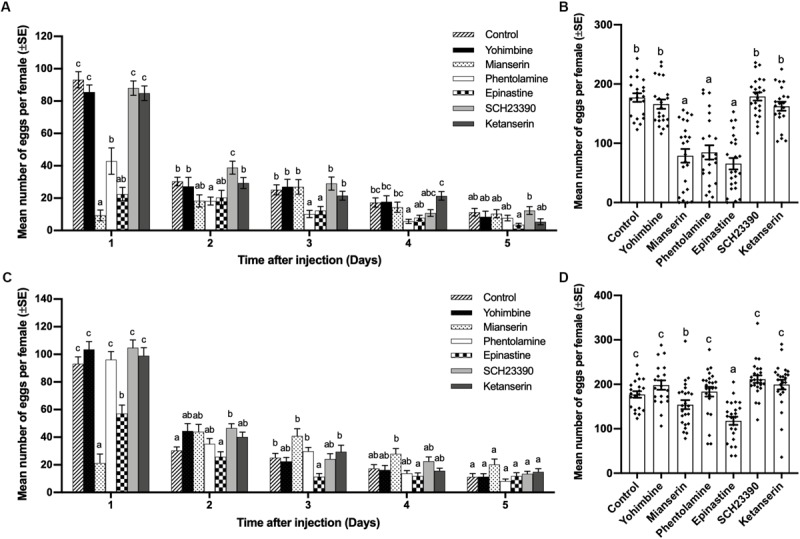
Effect of different biogenic amine antagonists on mating-induced oviposition by Plutella xylostella. Number of eggs laid by mated females from days 1–5 after injection with 0.3 μL of 0.02 mol/L (A) or 0.005 mol/L (C) antagonists and Milli-Q water as a control (20 ≤ n ≤ 24). Total number of eggs laid by mated females for 5 days after injection with 0.3 μL of 0.02 mol/L (B), or 0.005 mol/L (D) antagonists and Milli-Q water as a control (20 ≤ n ≤ 24). Individual data is displayed with dots. Different letters on the top of bars in (A–D) indicate significant differences between treatments on the same day (p < 0.05, ANOVA and Tamhane’s T2 test).